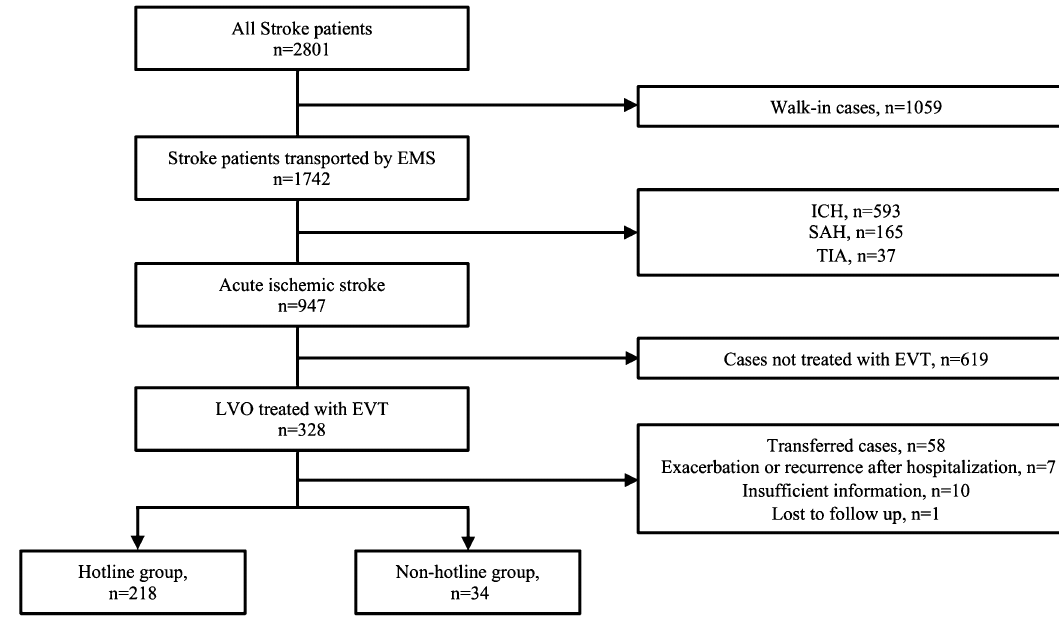
Figure 2. Study flowchart. EMS emergency medical services, EVT endovascular therapy, ICH intracranial hemorrhage, SAH subarachnoid hemorrhage, TIA transient ischemic